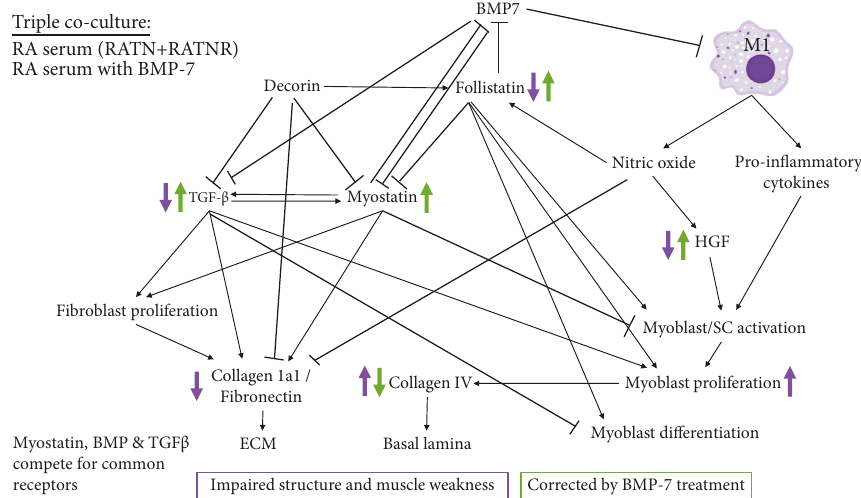
Figure 10: Summary of pathways implicated in the triple coculture experiment as proposed by literature. The purple arrows indicate the changes occurring as a result of RA patient serum-conditioned media. The green arrows indicated the changes occurring as a result of BMP- 7 treatment. BMP-7 � bone morphogenetic protein-7; HGF � hepatocyte growth factor; TGF- β � transforming growth factor- β